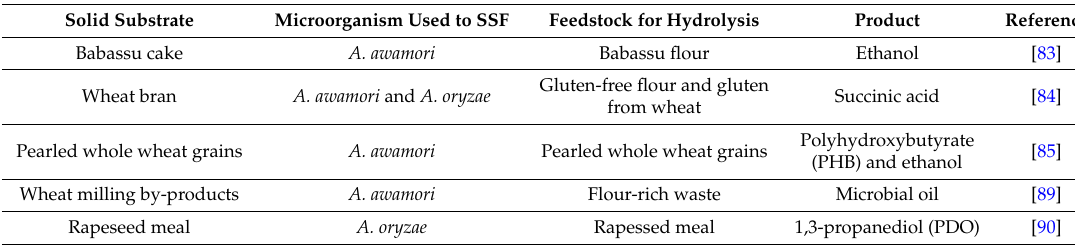
Table 2. Examples of products obtained by using generic